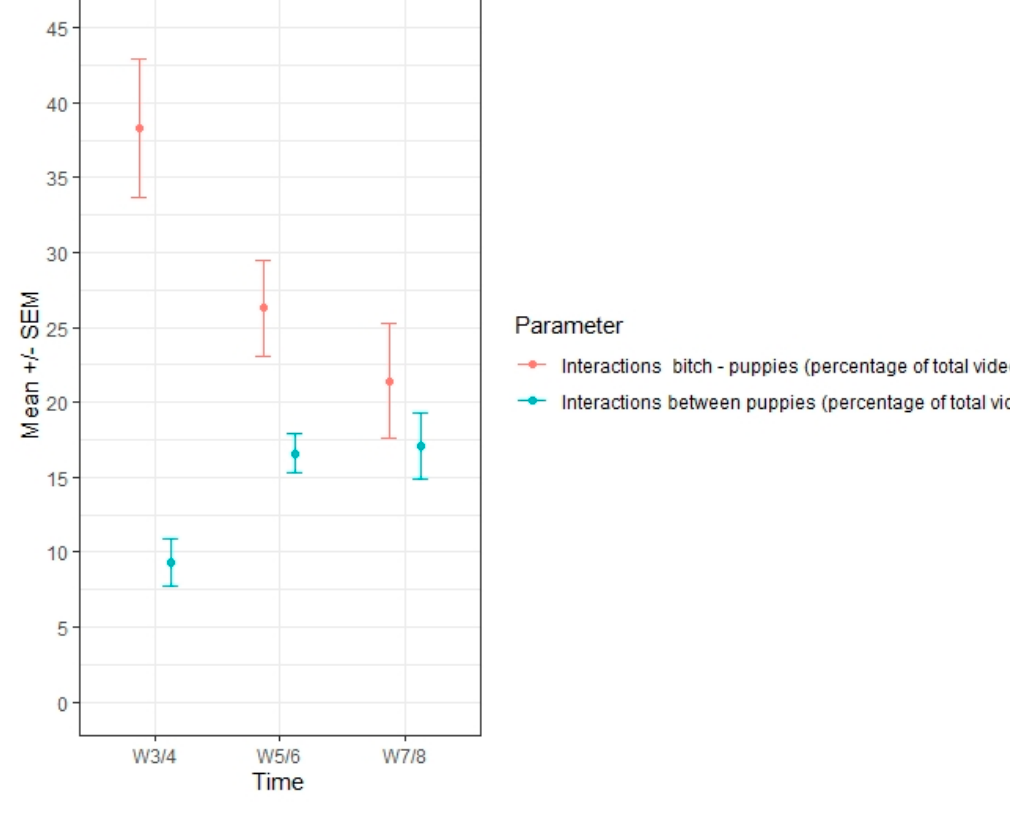
Figure 3. Proportional time dedicated to interactions from W3 / 4 to W7 / 8 postpartum ( n = 25 bitches). Comparison of the opposite evolutions throughout the weaning period of interactions amongst puppies and interactions between the dam and the puppies.